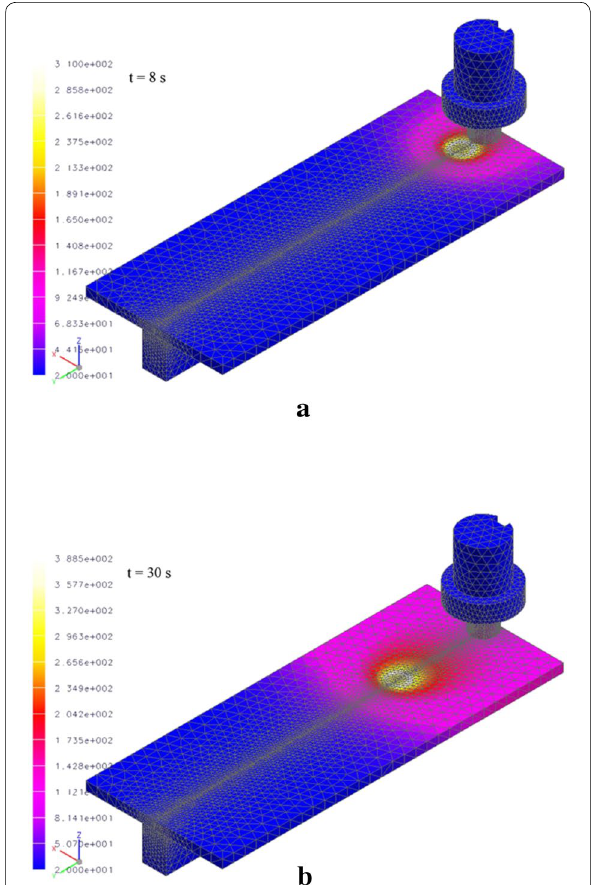
Figure 12 The contour plot of the welding including the welding and the backplate: ( a ) 5 s after the welding and ( b ) 30 s after the welding [72]